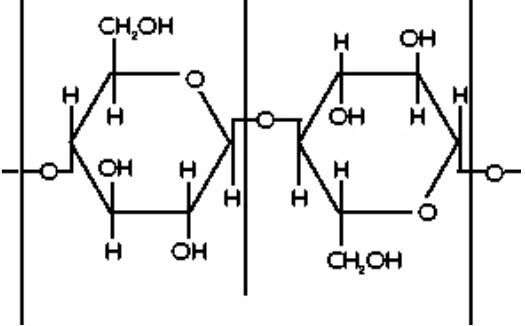
Figure 1. Drawing illustrates the chemical structure of cellulose detailing the hydroxyl, “OH”, water sorption sites.